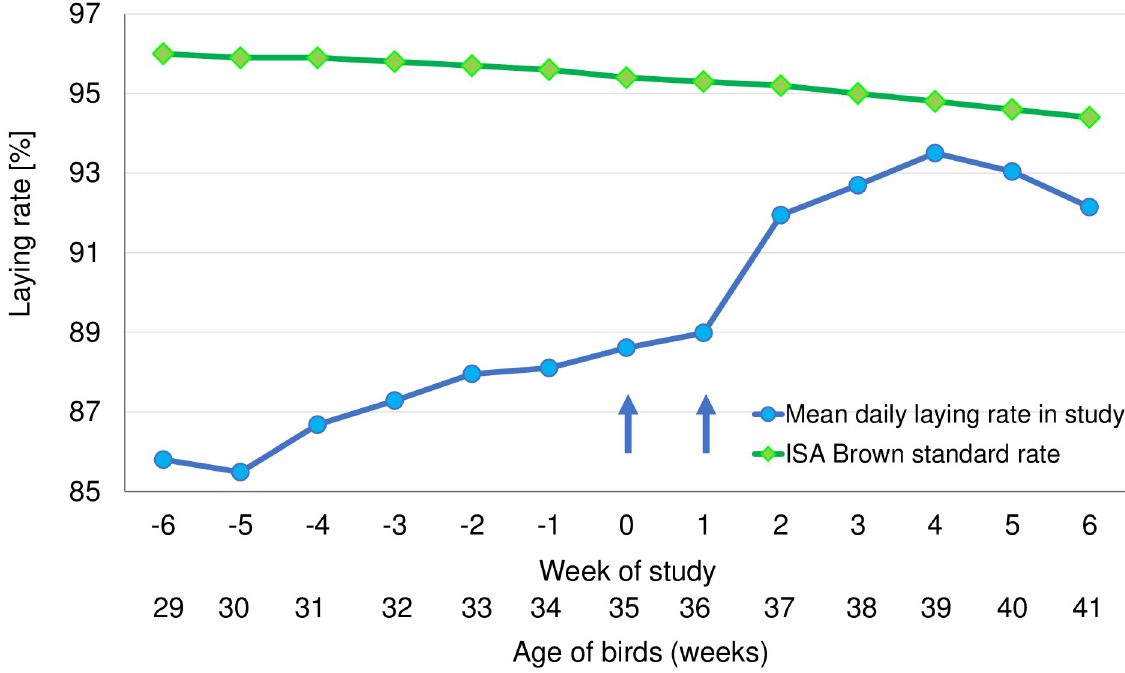
Fig 3. Weekly mean of daily egg laying rate of study hens before and after elimination of poultry red mites following acaricidal treatment and industry standard mean laying rates. Arrows indicate days of fluralaner administration (Weeks 0 and 1).